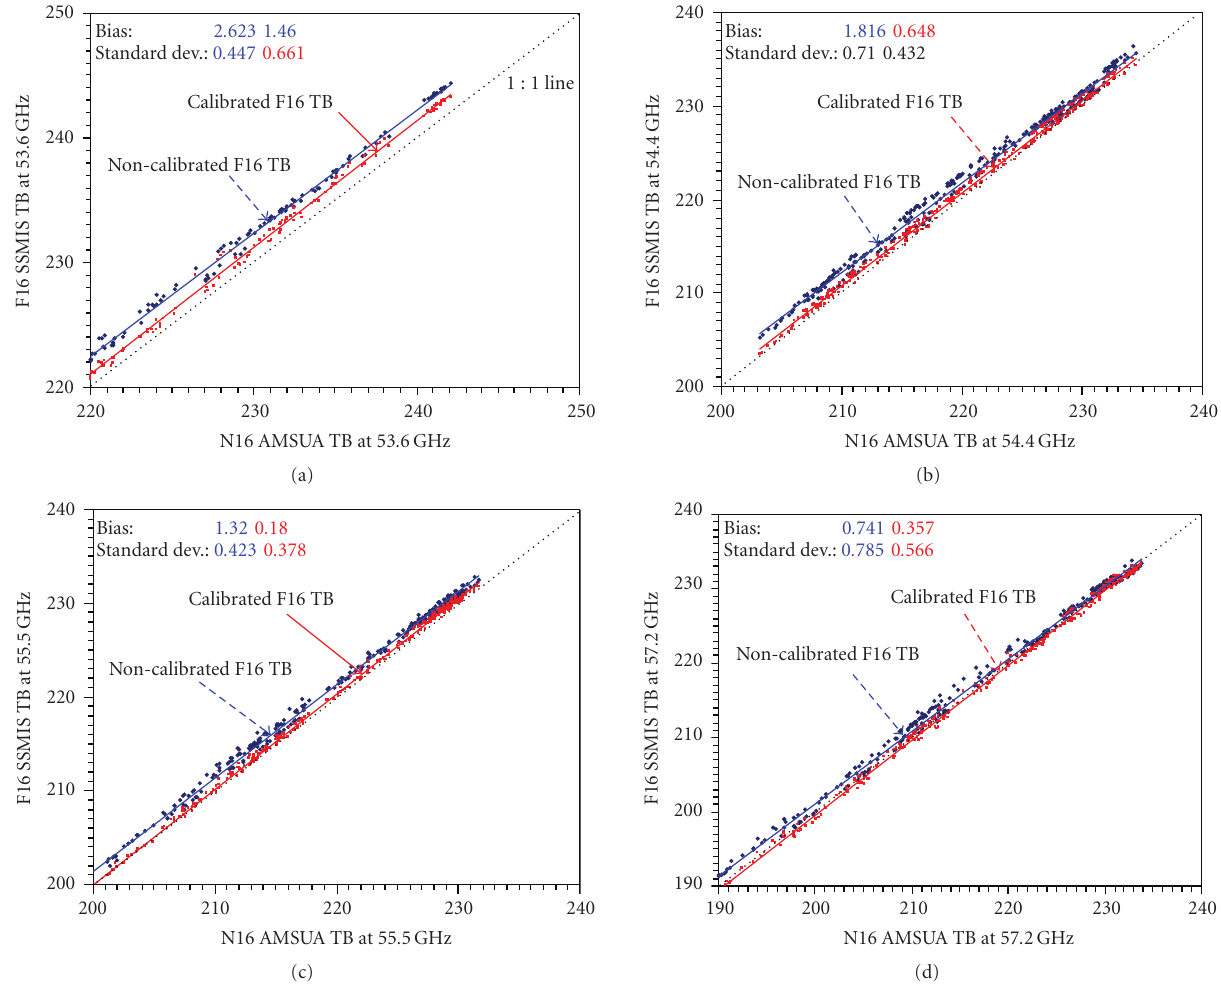
Figure 11: Intersatellite comparisons of brightness temperatures (TB) between F16 SSMIS TDR (CTDR) and NOAA-16 measurements at (a) 53.6 GHz, (b) 54.4 GHz, (c) 55.5GHz, and (d) 57.3GHz. In the figures, red is for newly calibrated while blue for original TDR